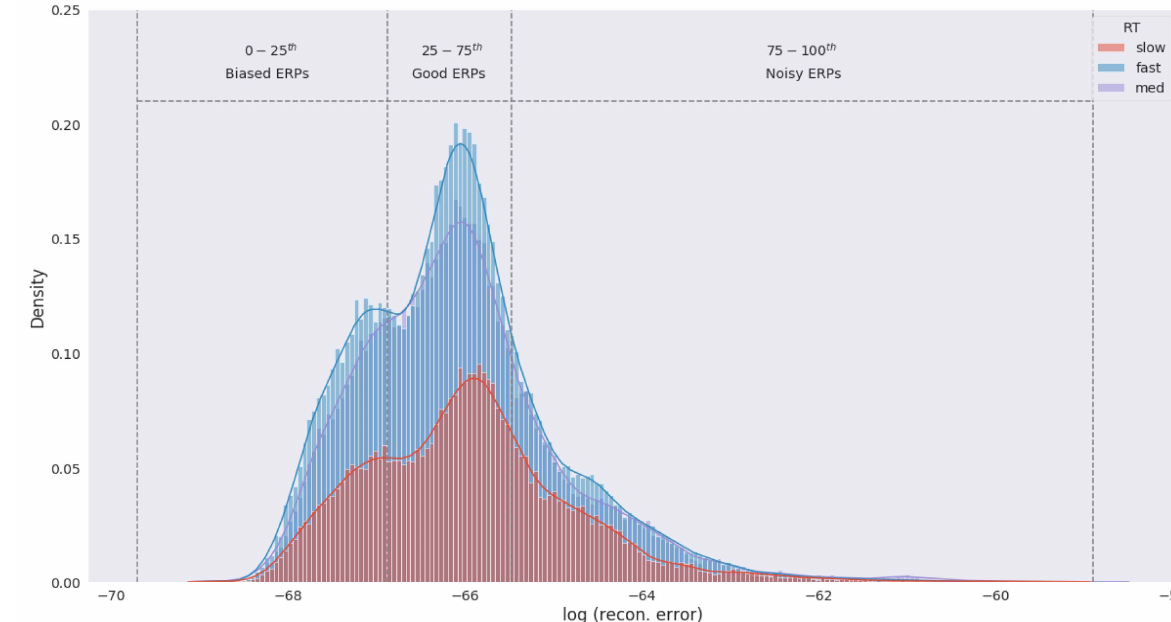
Figure 2. Distribution of ERP reconstruction error from the raw EEG eigenspace. Density was estimated by individual RT category through kernel density estimation (KDE). We consider ERPs within 0–25th percentile of the error distribution to be biased as these samples are far from the original EEG trials. Similarly, ERPs within 75–100th percentile are noisy due to close proximity to the raw EEG signals. ERPs within 25–75th percentile are considered samples with optimal variation and are selected for modeling